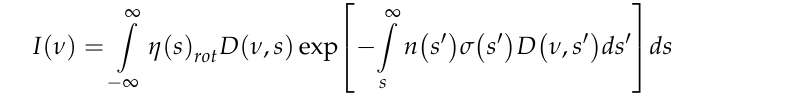
2 A -band airglow.